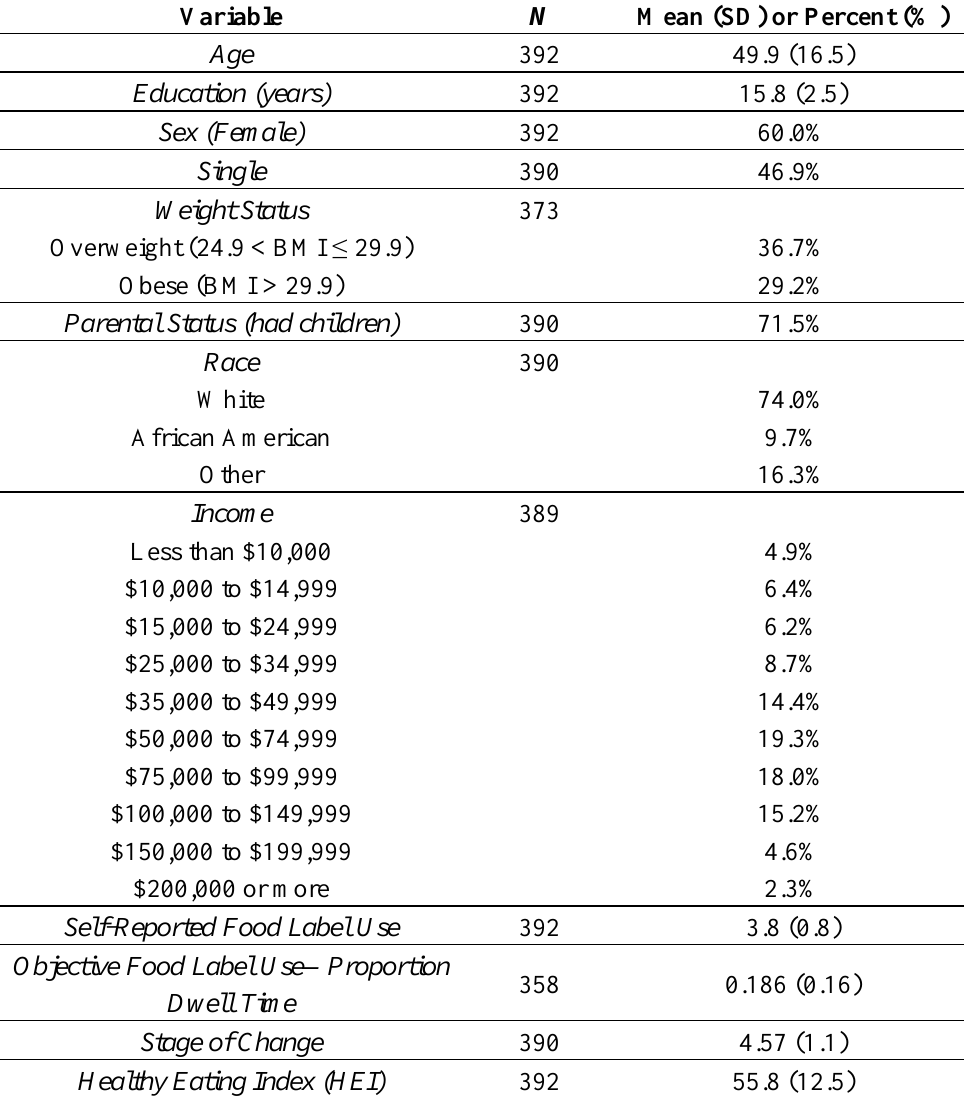
Table 1. Demographics and Summary